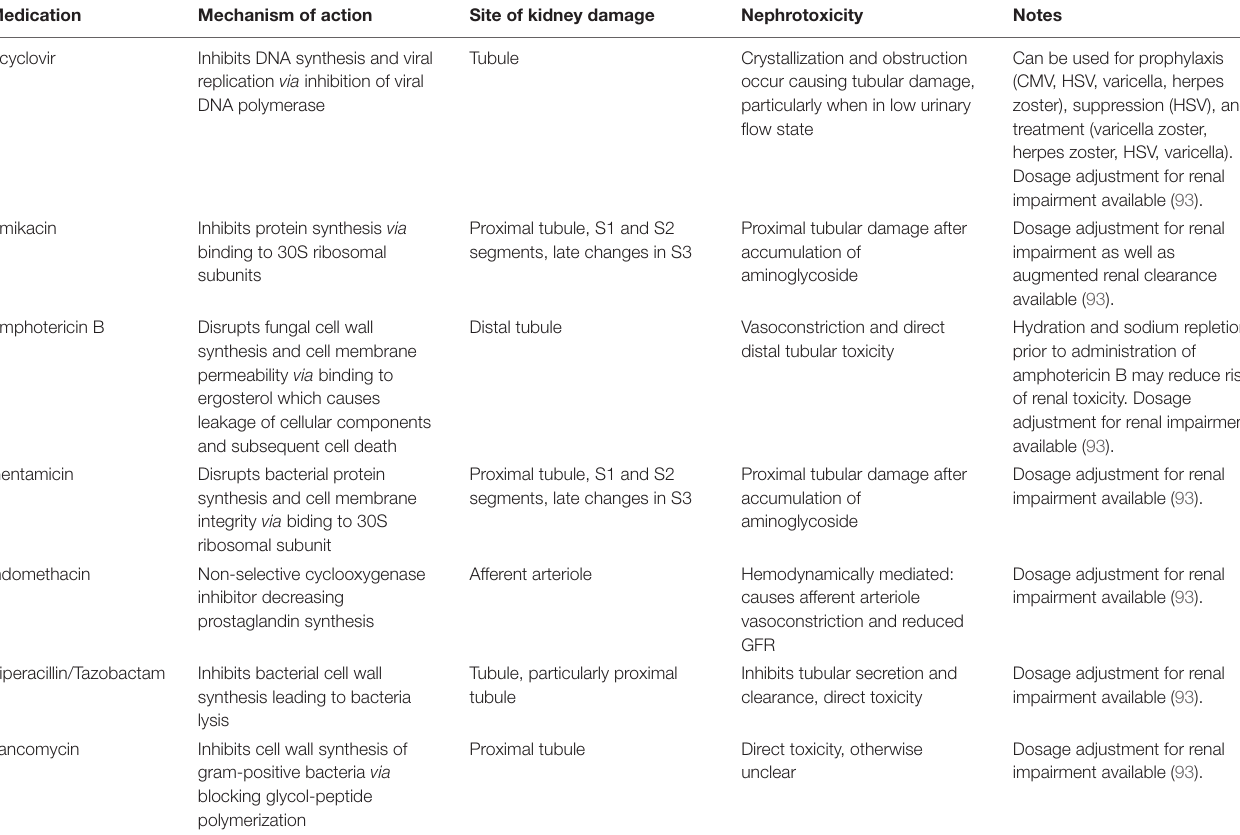
TABLE 3 | Nephrotoxic medications frequently used in